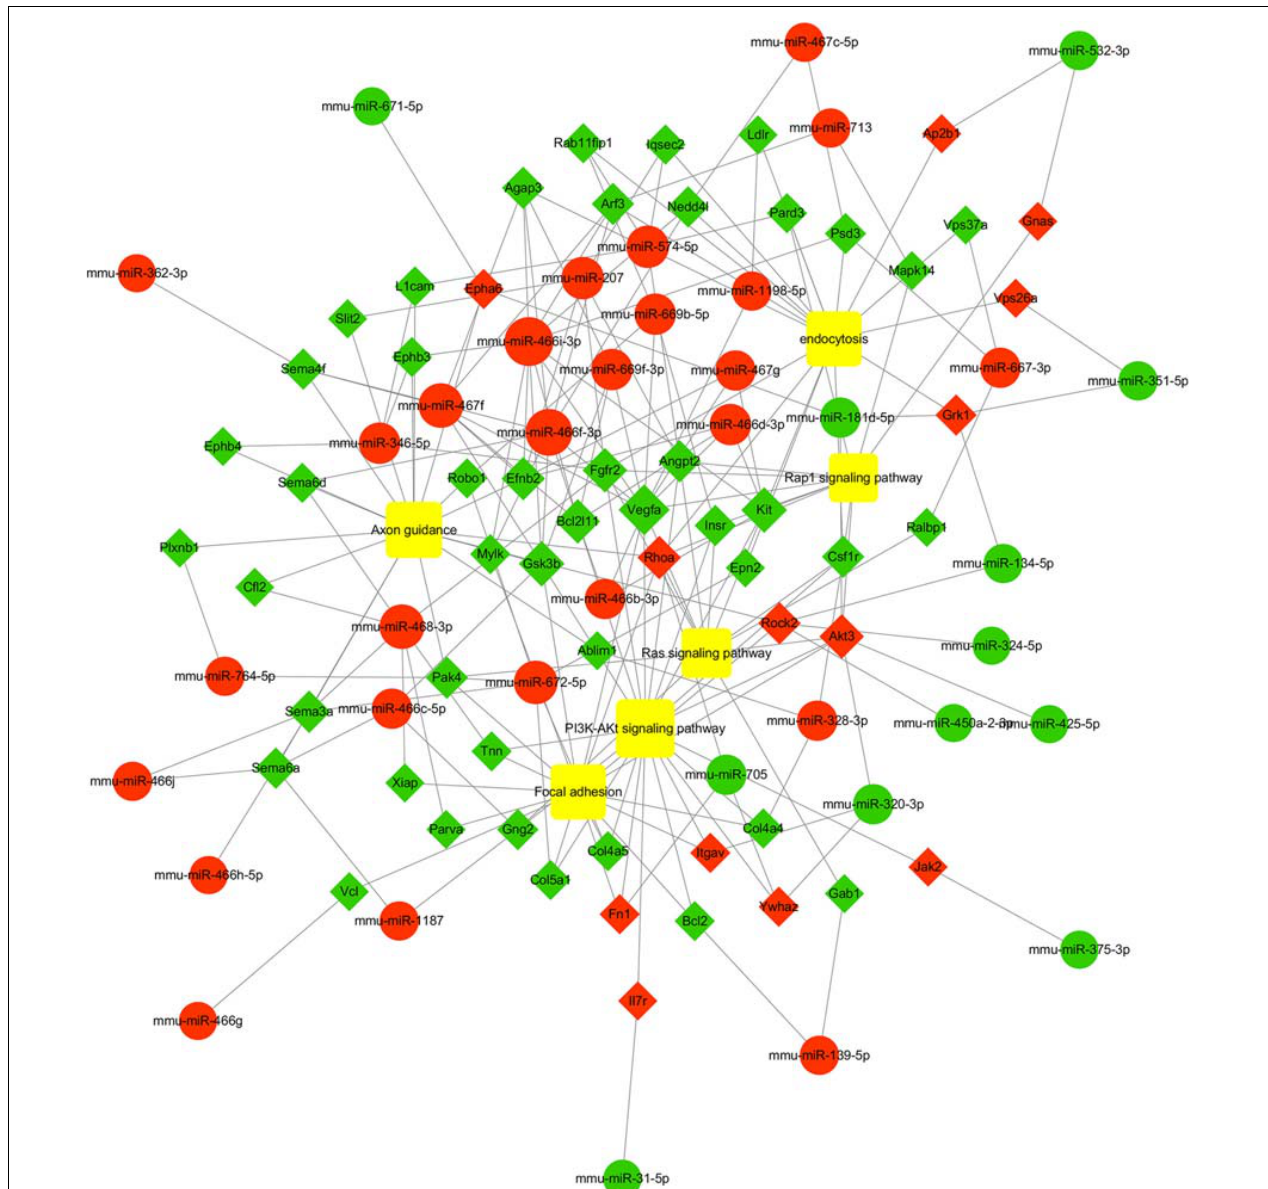
FIGURE 7 | miRNA-mRNA interaction network of intersectional inversed genes of miRNAs common to the three PB2-variant groups. Circles indicate identified miRNAs, while diamond represents the corresponding target genes. Red indicates up-regulated miRNAs or mRNAs while green indicates down-regulated miRNAs or mRNAs. The relationship between miRNAs and genes is shown connected by gray lines. The larger the circle is, the greater the degree to which the miRNA or gene involved in the related pathway. Six significant enriched pathways associated with influenza virus infection were depicted using the yellow squares. More details about miRNA-mRNA involved in these six pathways are shown in Supplementary Table S11